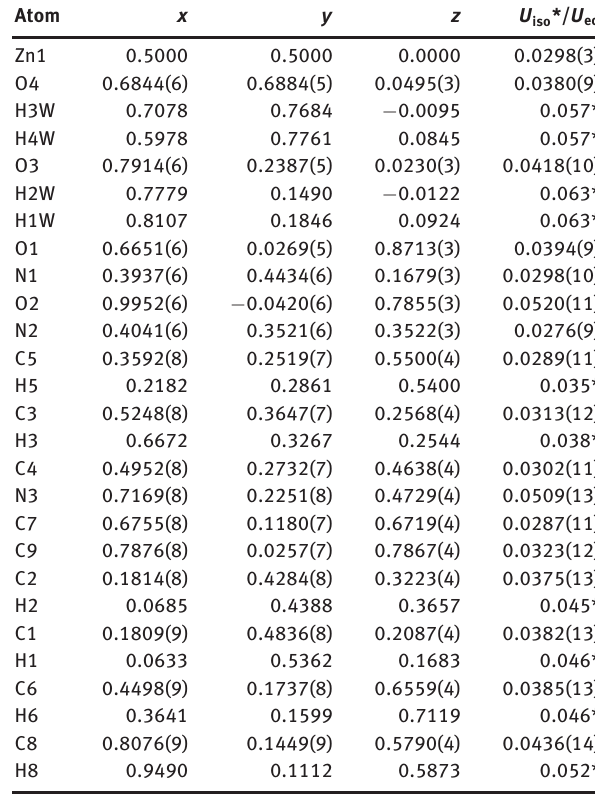
Table 1: Data collection and handling.